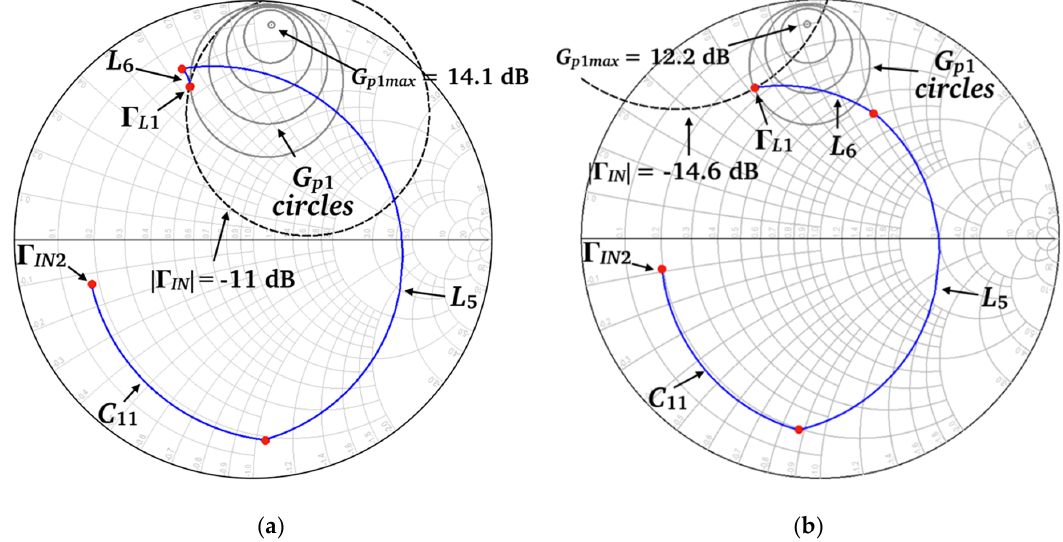
Figure 3. Inter-stage matching network (ISMN) design and plots of constant G p 1 circles and constant F and |  IN | circles on the  L 1 plane. ( a ) 120 GHz frequency state; ( b ) 140 GHz frequency